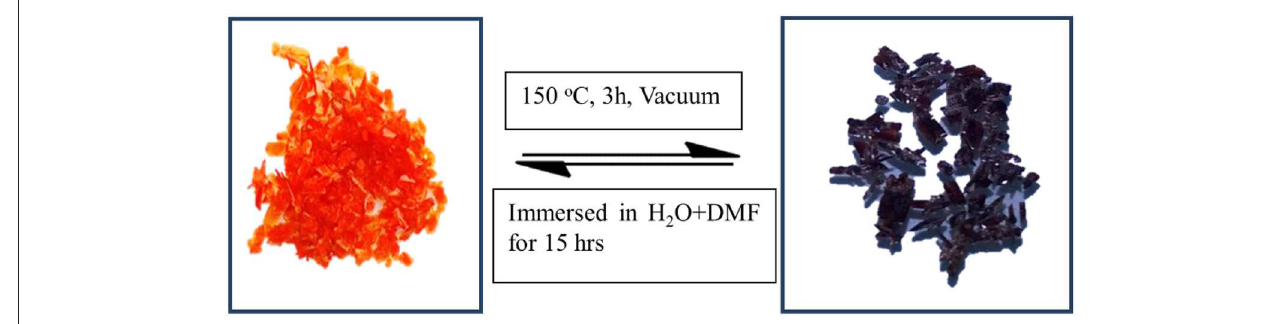
FIGURE 2 | Optical images of compound 1 , ( Left ), and compound 2 , ( Right ), clearly indicating a color change from orange to deep purple.